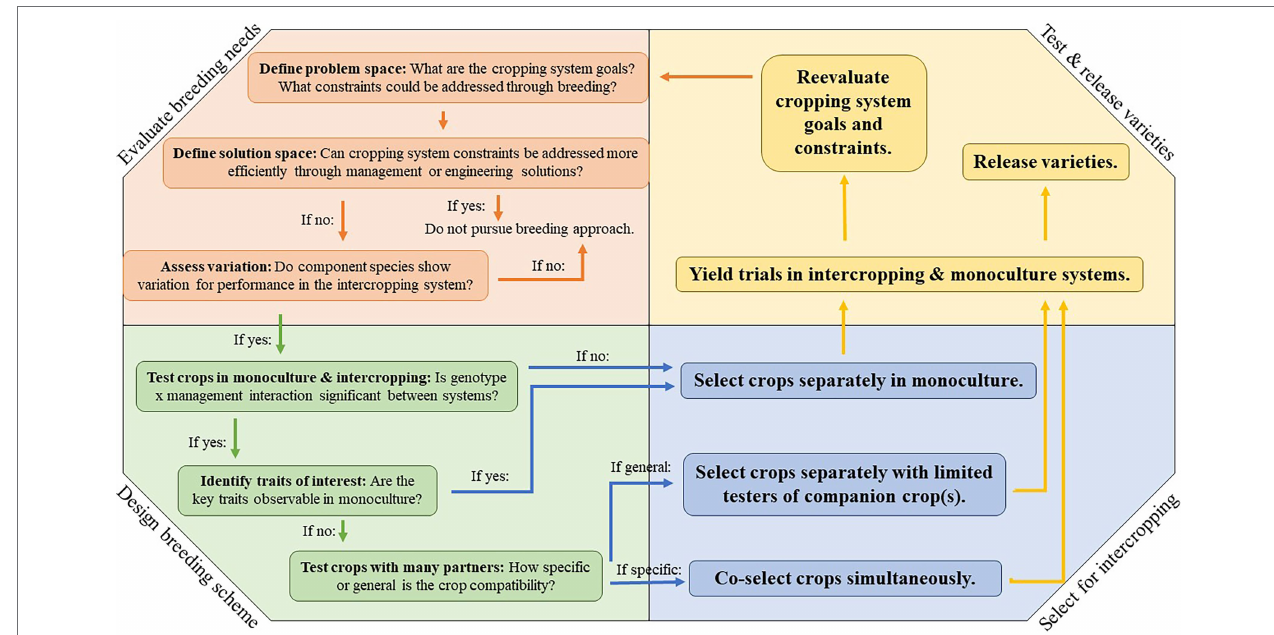
FIGURE 1 | The process of breeding for intercropping